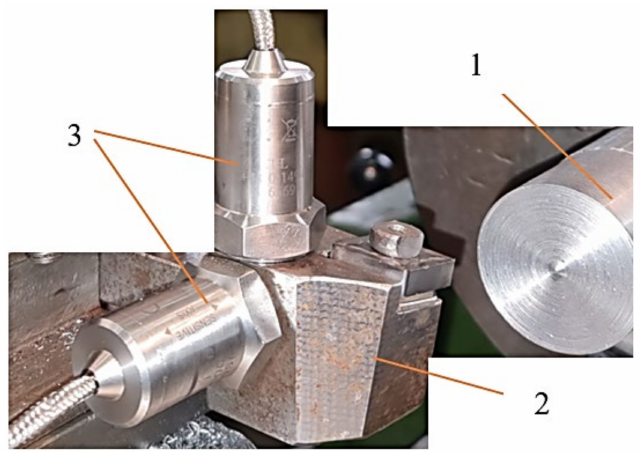
Figure 5. The arrangement of accelerometers: 1—workpiece; 2—tool;